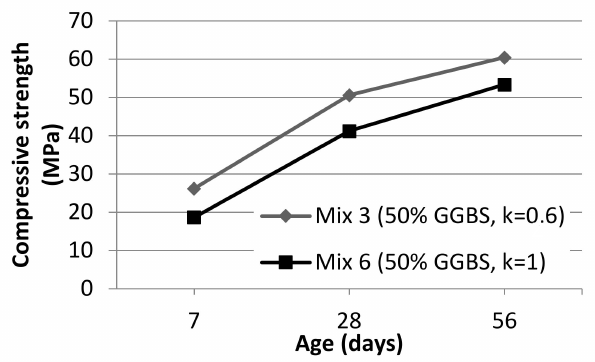
Figure 12. Compressive strength development of concretes with 50% GGBS, air = 4.5%, cured at 20 ◦ C and with di ff erent e ffi ciency